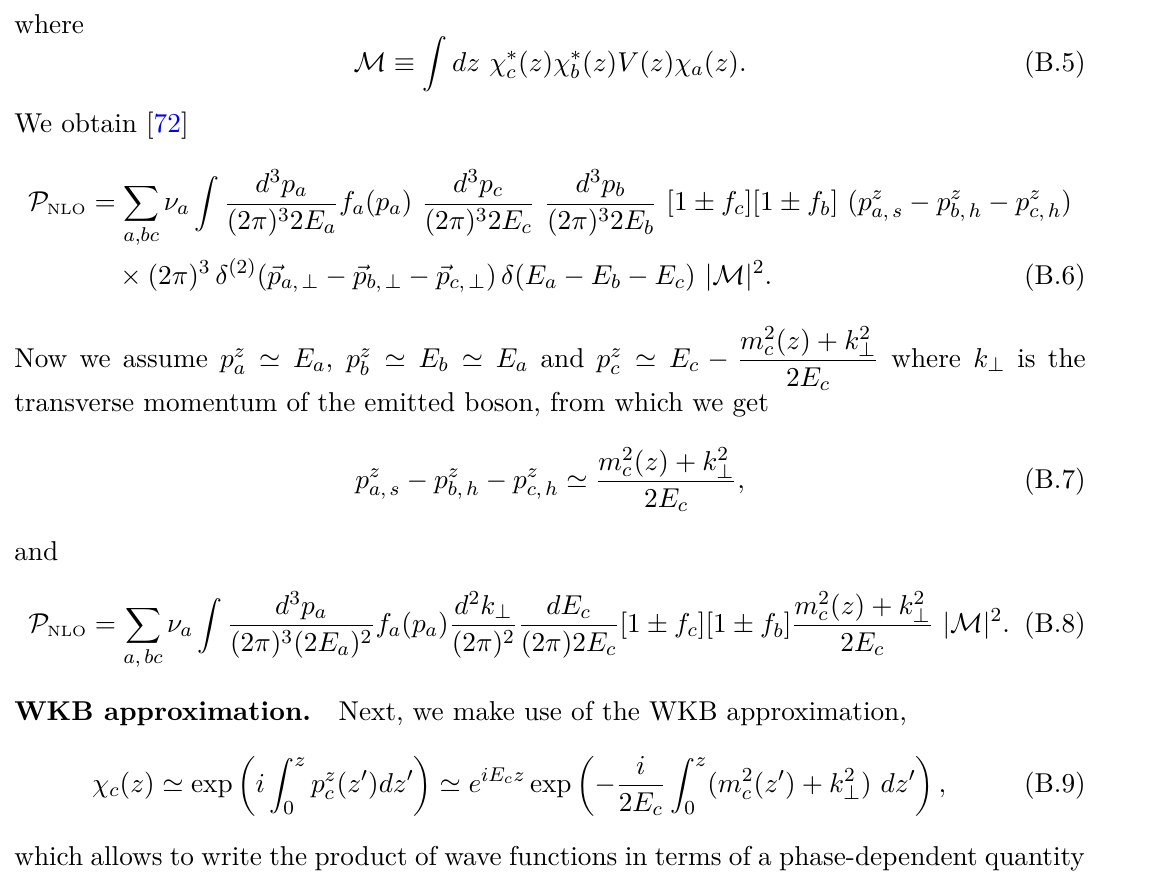
Figure 12 . NLO contribution to the retarding pressure: while entering inside the bubble wall, an incoming particle ‘ a ’ radiates a vector boson ‘ c ’ which gets a mass in the confined phase.